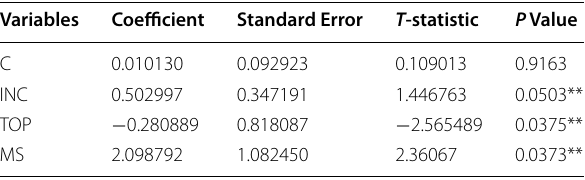
Table 6 Estimated long-run coefficients using the